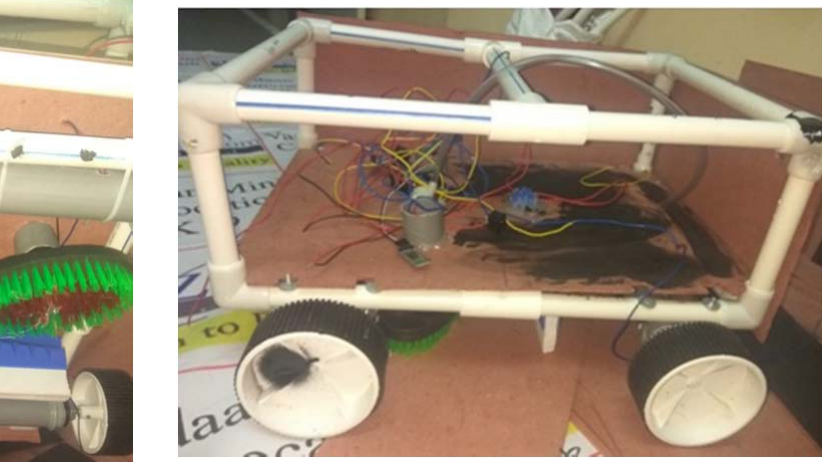
Figure 4. Bottom view of brush connection.